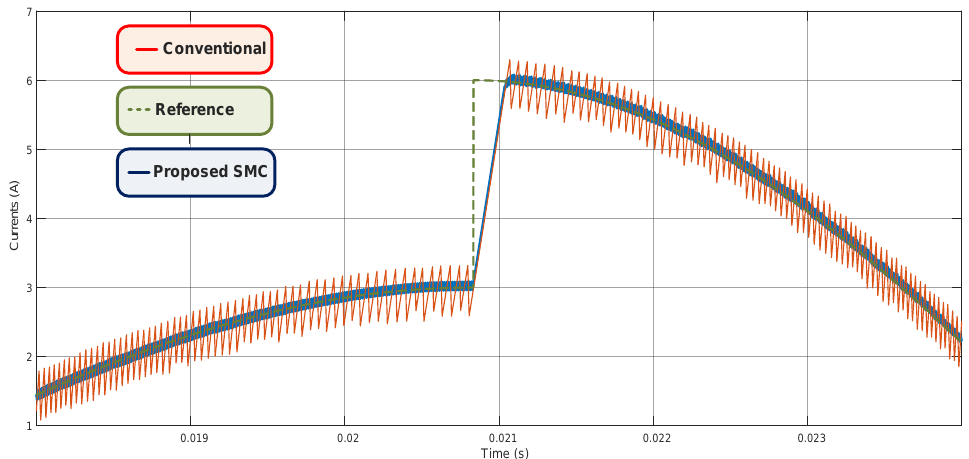
Figure 12. Comparison of the traditional and proposed SMCs.